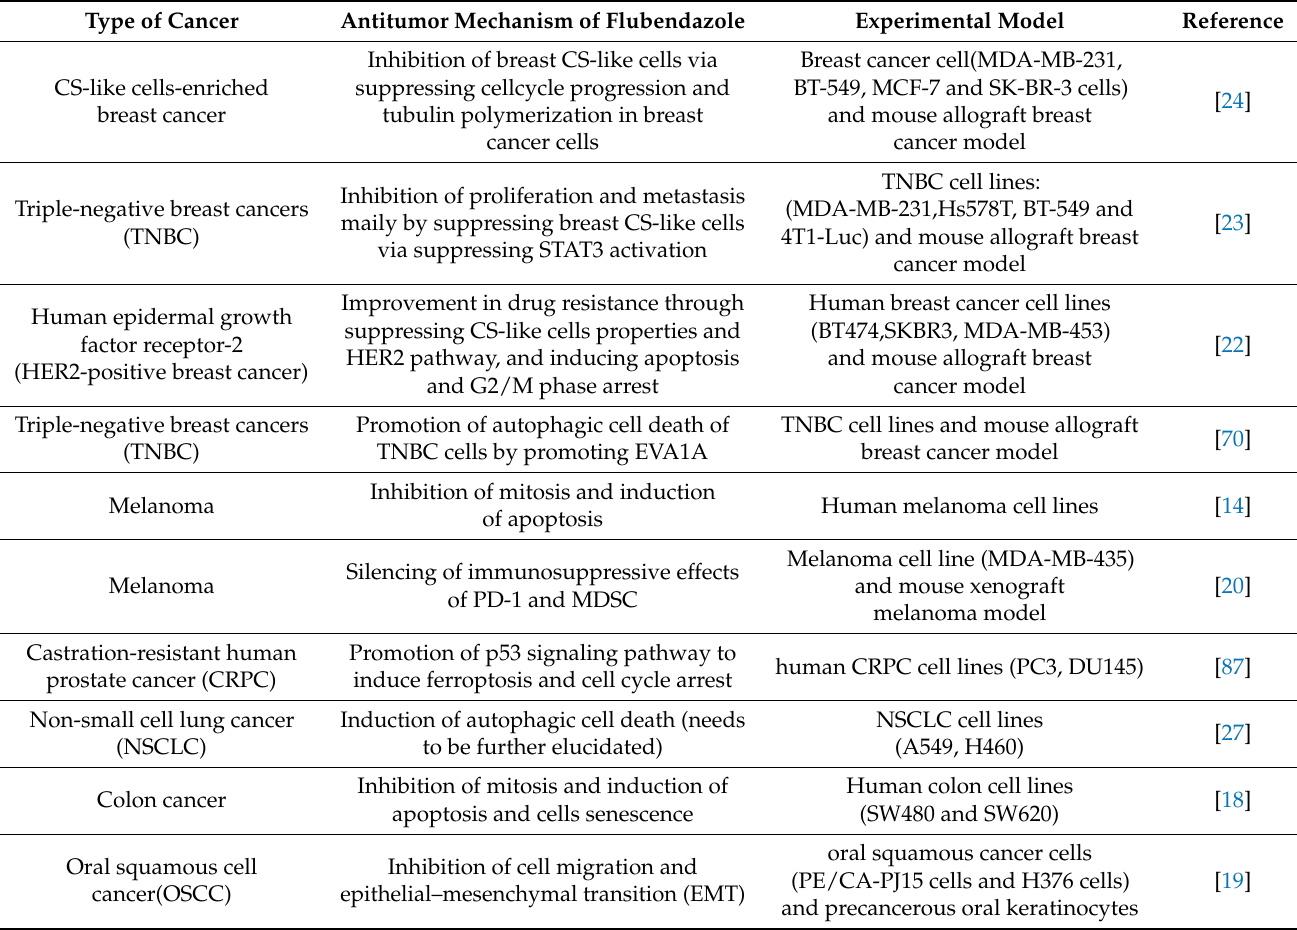
Table 1. Summary of antitumor effects of flubendazole in different